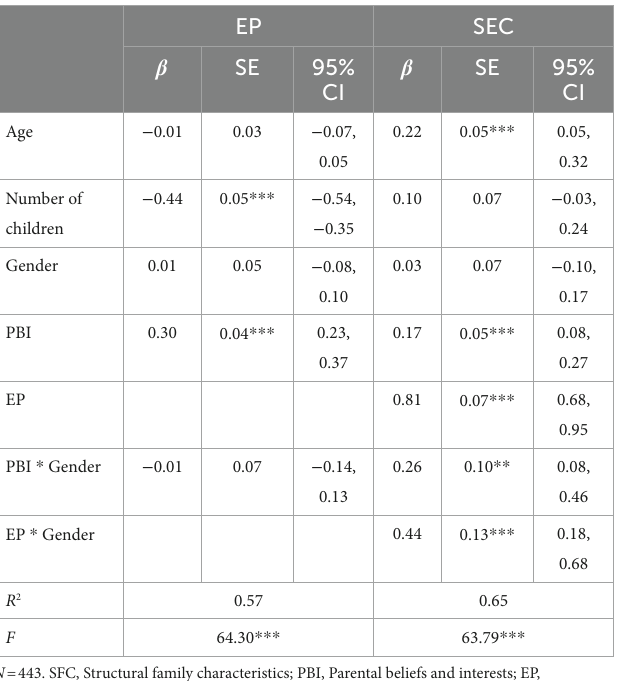
TABLE 3 Tests of the moderated mediation effect A.